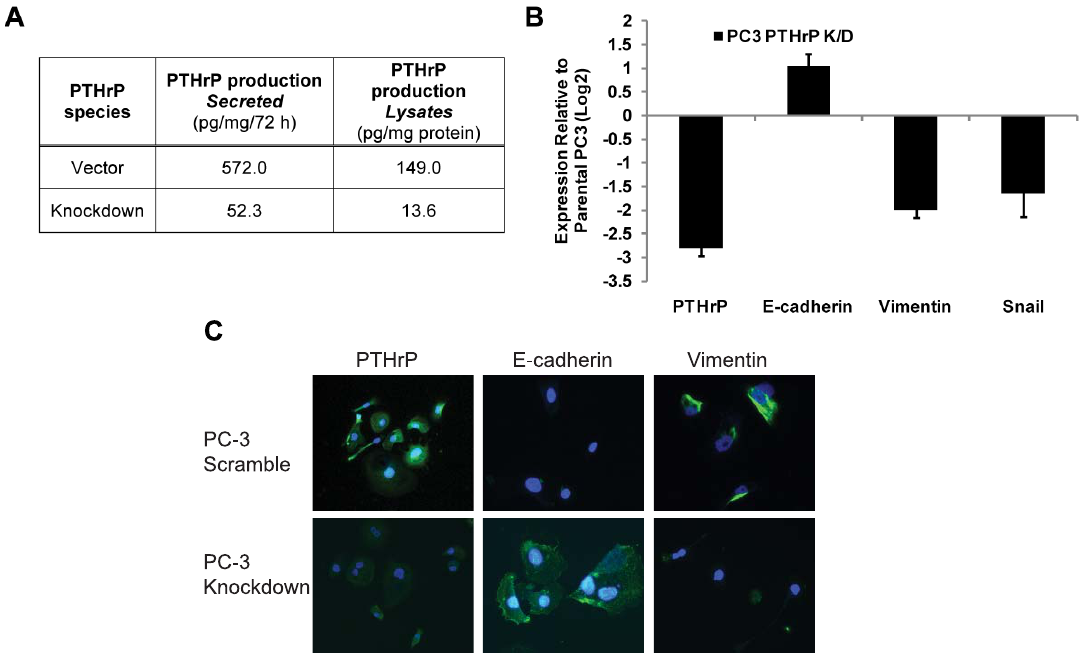
Figure 2. PTHrP Knockdown reverses EMT. A) Quantification of PTHrP protein levels in control and PTHrP-knockdown PC-3 cells by immunoassay. B) mRNA expression of PTHrP and EMT markers in control and PTHrP-knockdown PC-3 cells. C) Immunofluorescence images confirming the overexpression of PTHrP the upregulation of vimentin, and downregulation of E-cadherin in control and PTHrP-knockdown PC-3 cells.